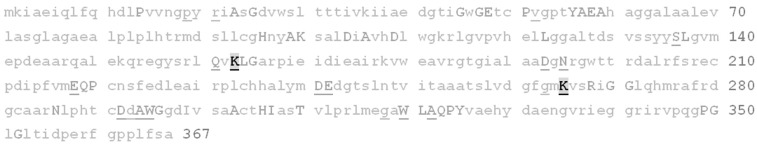
Prediction performance of PINGU on 4-hydroxyproline betaine 2-epimerase.The alphabets in upper case indicate PINGU predictions; alphabets underlined are predicted ligand binding residues; and those highlighted are catalytic residues.